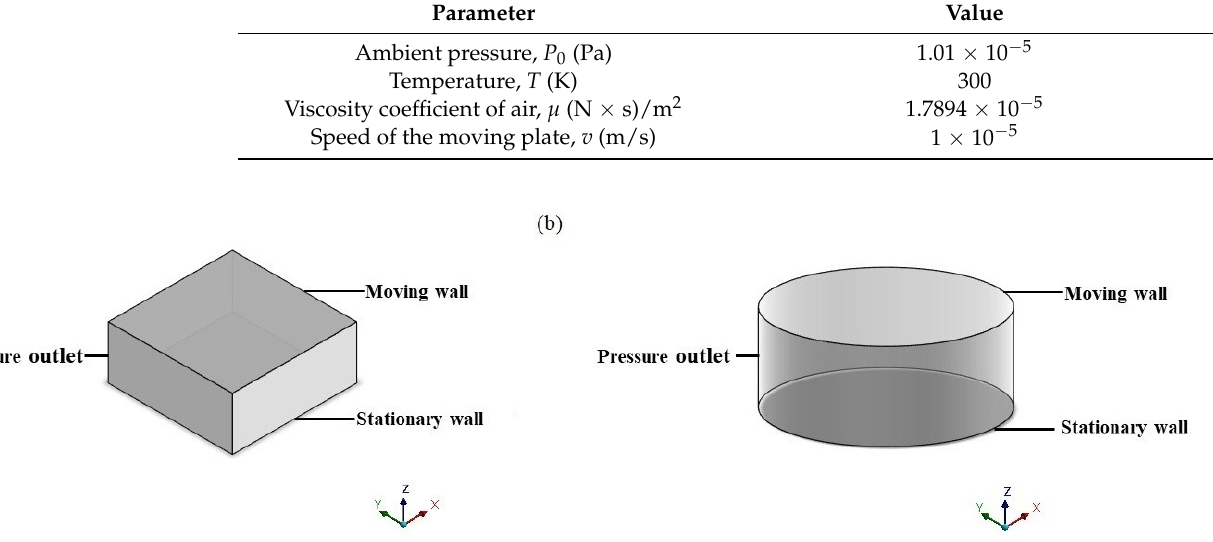
Figure 2. Physical simulation geometries of the ( a ) rectangular plate and ( b ) circle plate with the finite size effect only.